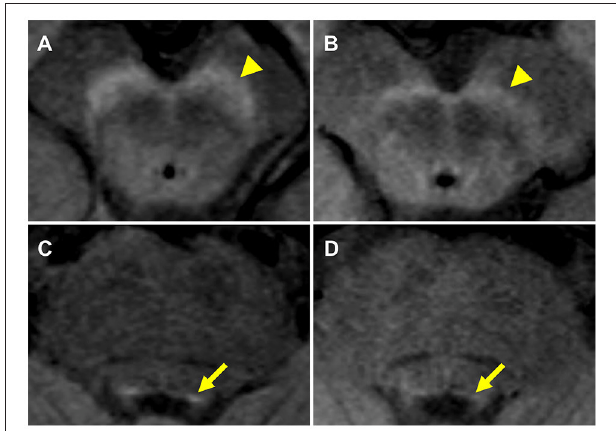
FIGURE 1 | NM-MRI of the substantia nigra and locus coeruleus. NM-MRI images at the levels of the substantia nigra (arrowhead) and the locus coeruleus (arrow) of a 66-year-old healthy woman (A,C) and a 70-year-old man with PD (B,D)